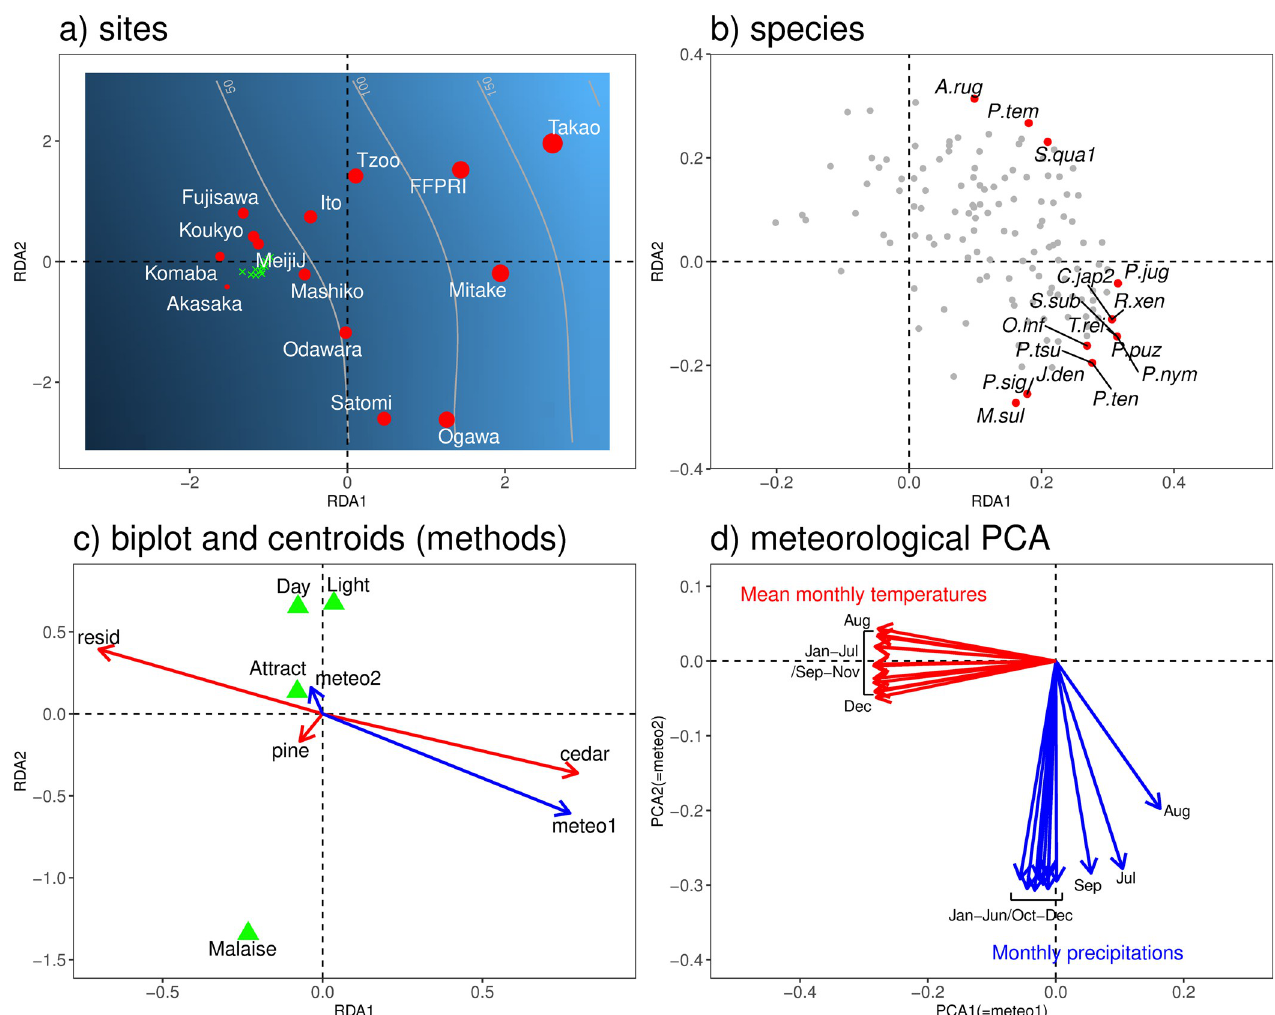
Fig 3. RDA ordination diagram of species composition of longhorn beetles across the 14 study sites in the Kanto region (a: plot by sites, b: species plot, c: biplot and centroids of factors), and biplot of climatic PCA (d). Total number of species were overlayed as contour, gradient, and the size of the points (a brighter gradient and a bigger point indicate a greater number of species) in panel a. Ad-hoc plots of the 12-year data from Ito were also overlaid onto panel a (green crosses). Only 16 species, whose locations are furthest from the ordination centre, are shown in panel b (See S2 Table for abbreviations of species). Factors are plotted as arrows, but the methods (Day, Light, Attract, and Malaise) are as the centroids of the stations in panel c. meteo1 and meteo2 in RDA are the coordinates of stations in the metrological PCA of panel